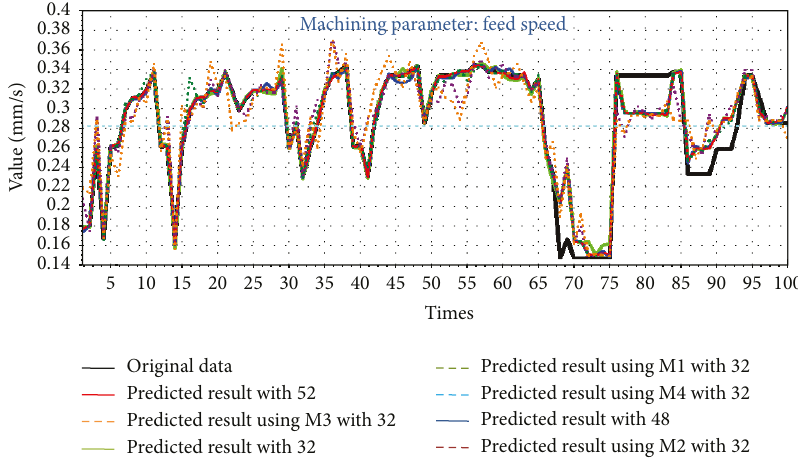
Figure 15: Predicted results of feed speed of grinding wheel.